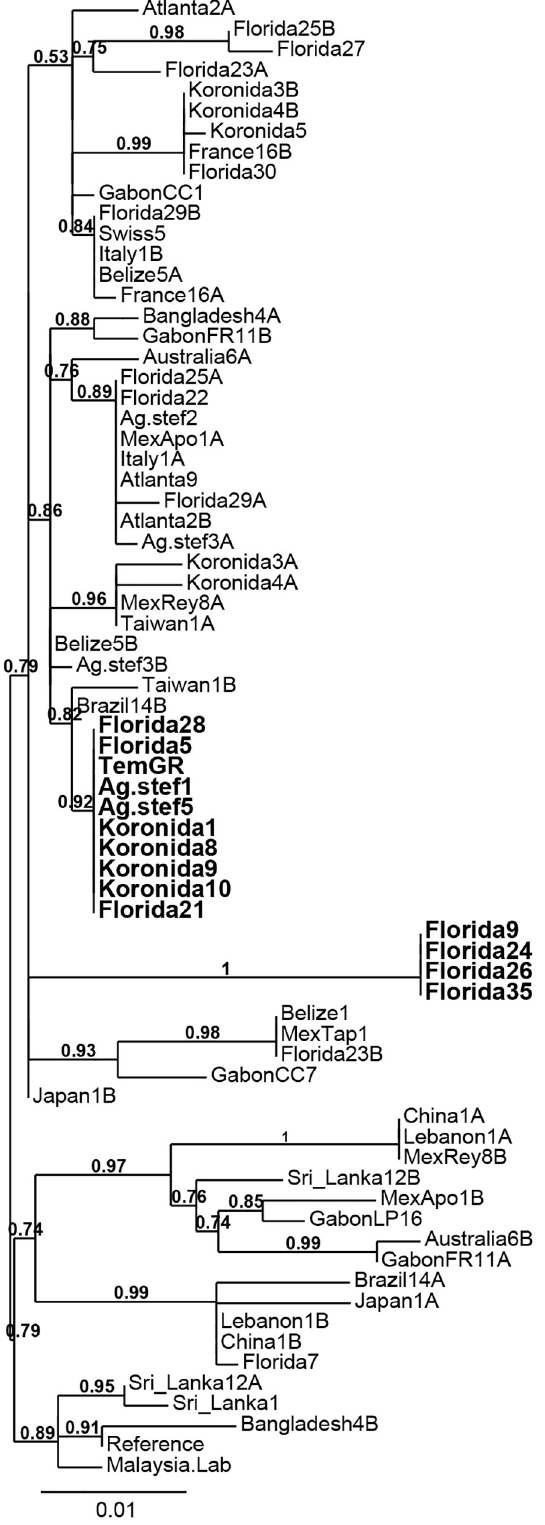
Fig 4. CCEae3a diversity. An unrooted maximum likelihood tree was built to represent the phylogenetic distancesbetween the 45 CCEae3a haplotypes identifiedworldwide(see also S1 Table). Distances